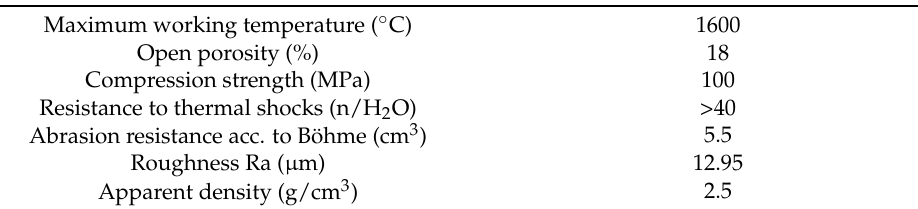
Table 3. Properties of silicon carbide.